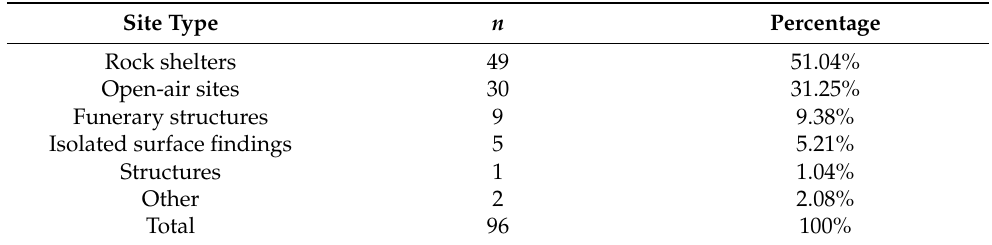
Table 1. The archaeological record of the southern coast of General Carrera